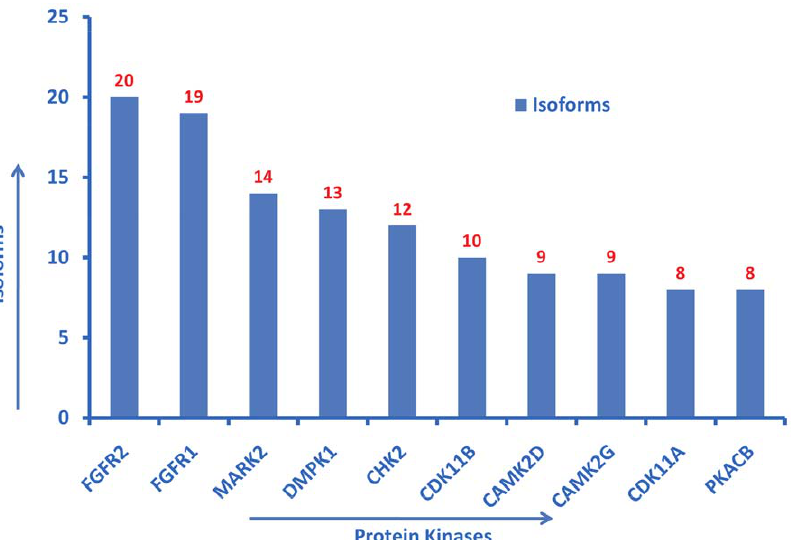
Figure 3. Counts of isoforms for all protein kinases. Top 10 kinases are displayed in descending order of their values. The Y-axis shows the number of validated isoforms for each of the kinass. The SPARQL query used to generate this figure can be viewed and excuted from the ProKinO browser by selecting ‘‘Query 2’’ under the ‘‘Example queries’’ tab in the main page.